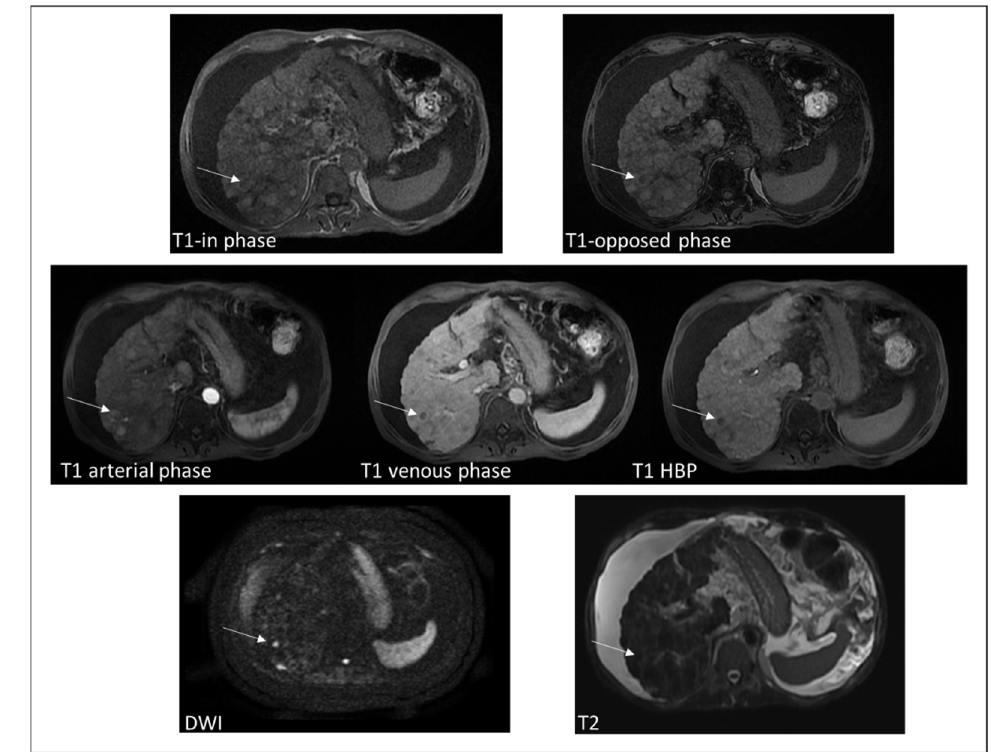
RS: refractory cytopenia with multilineage dysplasia and ringed sideroblasts; TACE: transarterial chemoembolization.